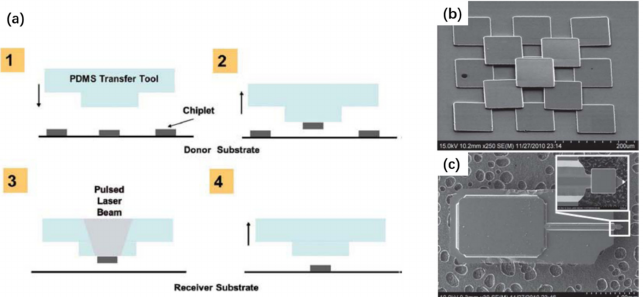
Figure 23. ( a ) Working principle of the laser-driven non-contact transfer printing based on a poly- dimethylsiloxane (PDMS) transfer head. ( b ) Three-dimensional pyramid built with silicon squares. ( c ) Silicon square placed on a silicon cantilever. Adapted with permission from [261]. Copyright IEEE, 2012.